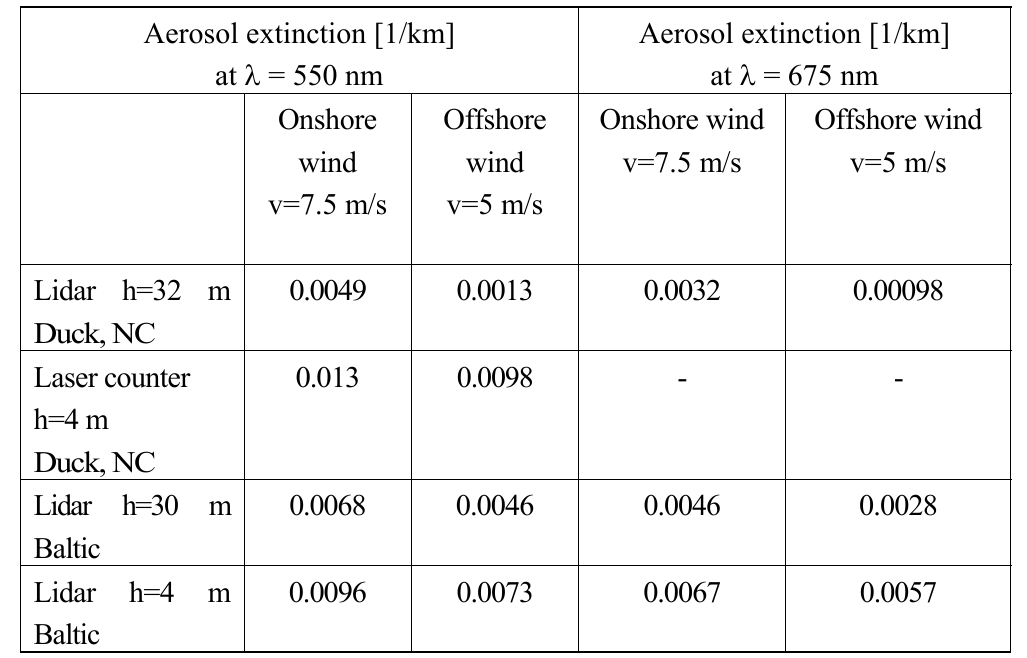
Table 5. Aerosol extinction coefficients obtained with lidar and laser particle counters (CSASP-100- HV-SP) at two altitudes in Duck, NC and Lubiatowo at the Baltic